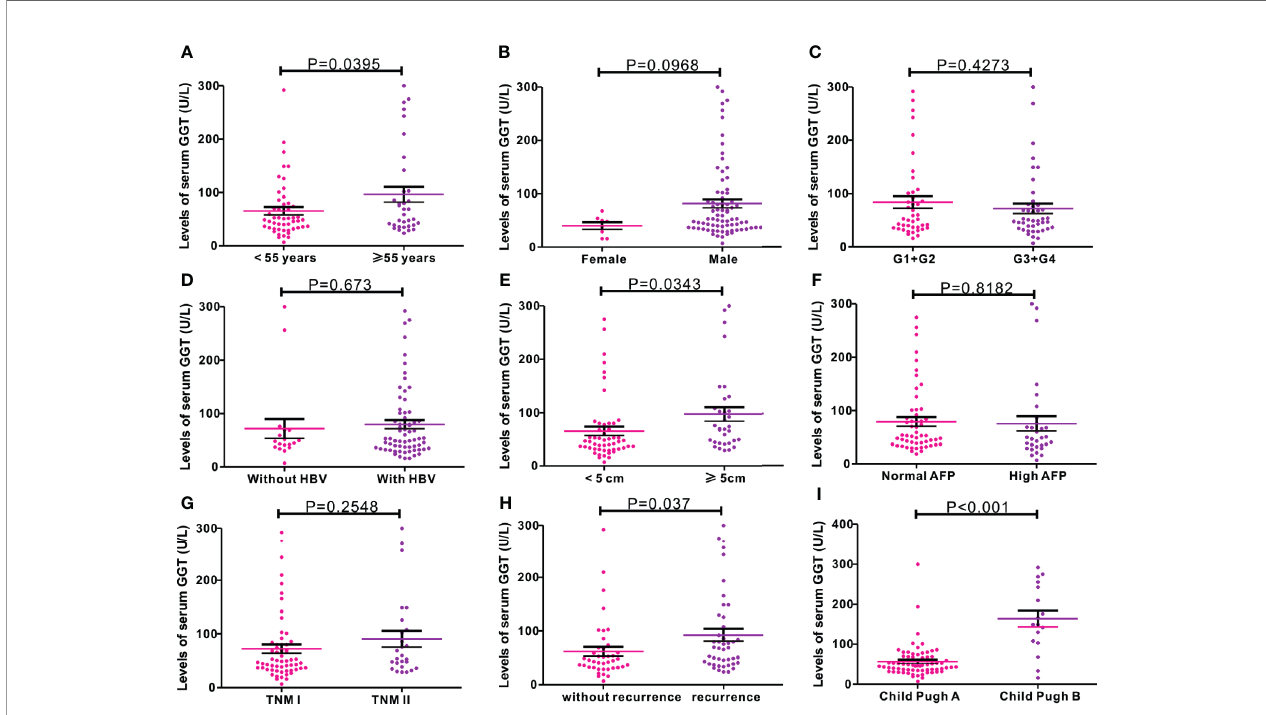
FIGURE 3 | Correlations of serum GGT protein with common clinical variables in 85 cases of early-stage HCC patients from Renmin cohort. (A) age (P = 0.0395); (B) gender (P = 0.0968); (C) G stage (P = 0.4273); (D) HBV infection (P = 0.673); (E) tumor size (P = 0.0343); (F) AFP levels (P = 0.8182); (G) TNM stage (P = 0.2548); (H) tumor recurrence (P = 0.037); (I) Child Pugh grade (P < 0.001).